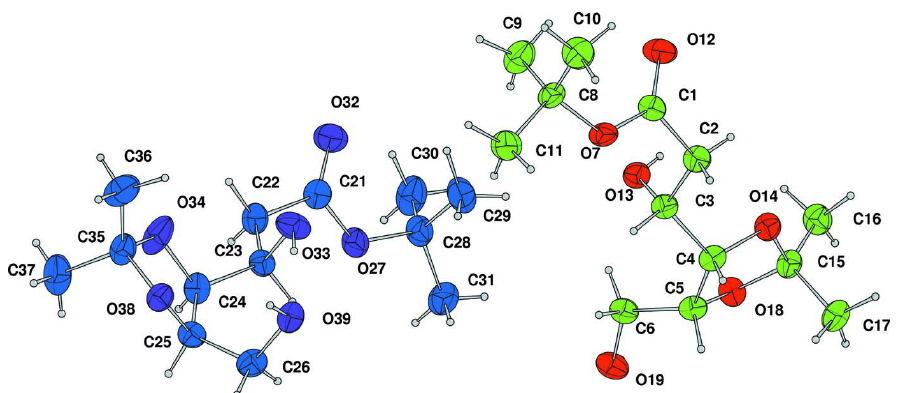
Figure 2 The title compound with displacement ellipsoids drawn at the 50% probability level. H atoms are shown as spheres of arbitary radius. There are two molecules in the asymmetric unit. Carbon atoms are shown in green (molecule 1) or blue (molecule 2) and oxygen atoms in red (molecule 1) or purple (molecule